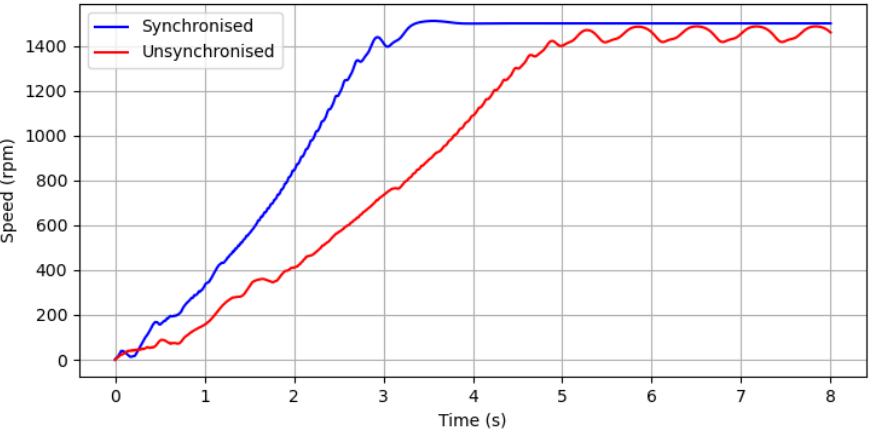
Figure 7. Speed vs. time graphs for a synchronized and un-synchronized